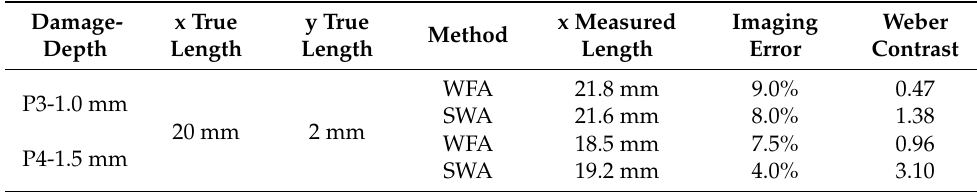
Table 3. Evaluation of damage imaging results of CFRP